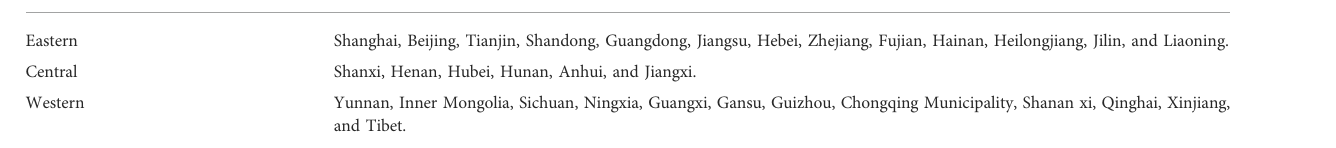
TABLE 10 Regional distribution in China.